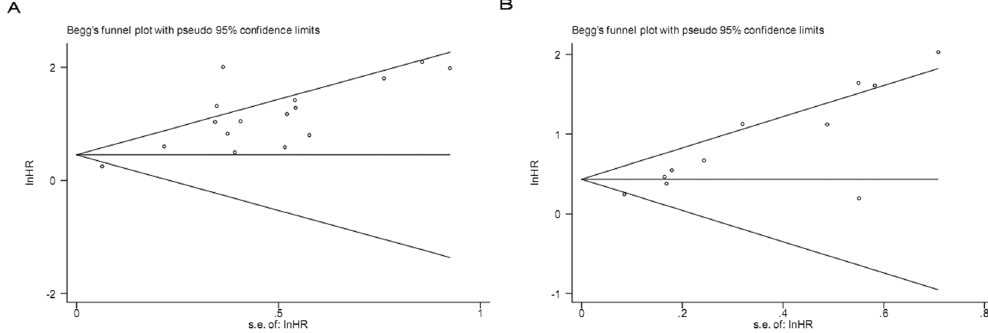
Figure 6. ( A ) Funnel plot of 16 included studies in this meta-analysis for OS; ( B ) Funnel plot of 11 included studies in this meta-analysis for